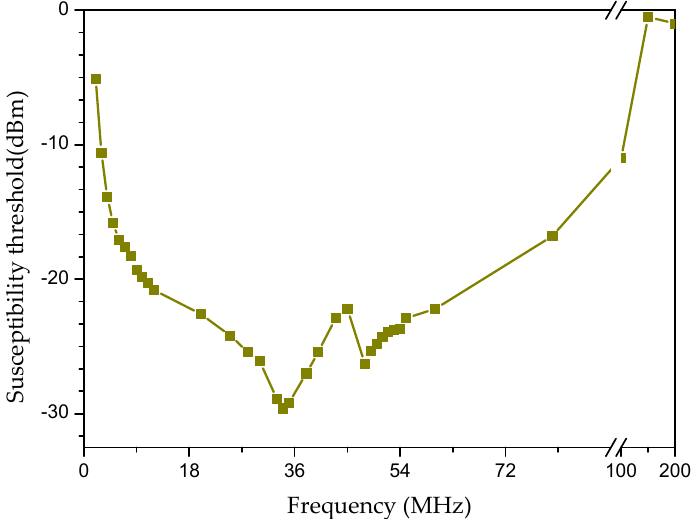
Figure 7. The susceptibility threshold curve of the laser ranging system under single-frequency interference.